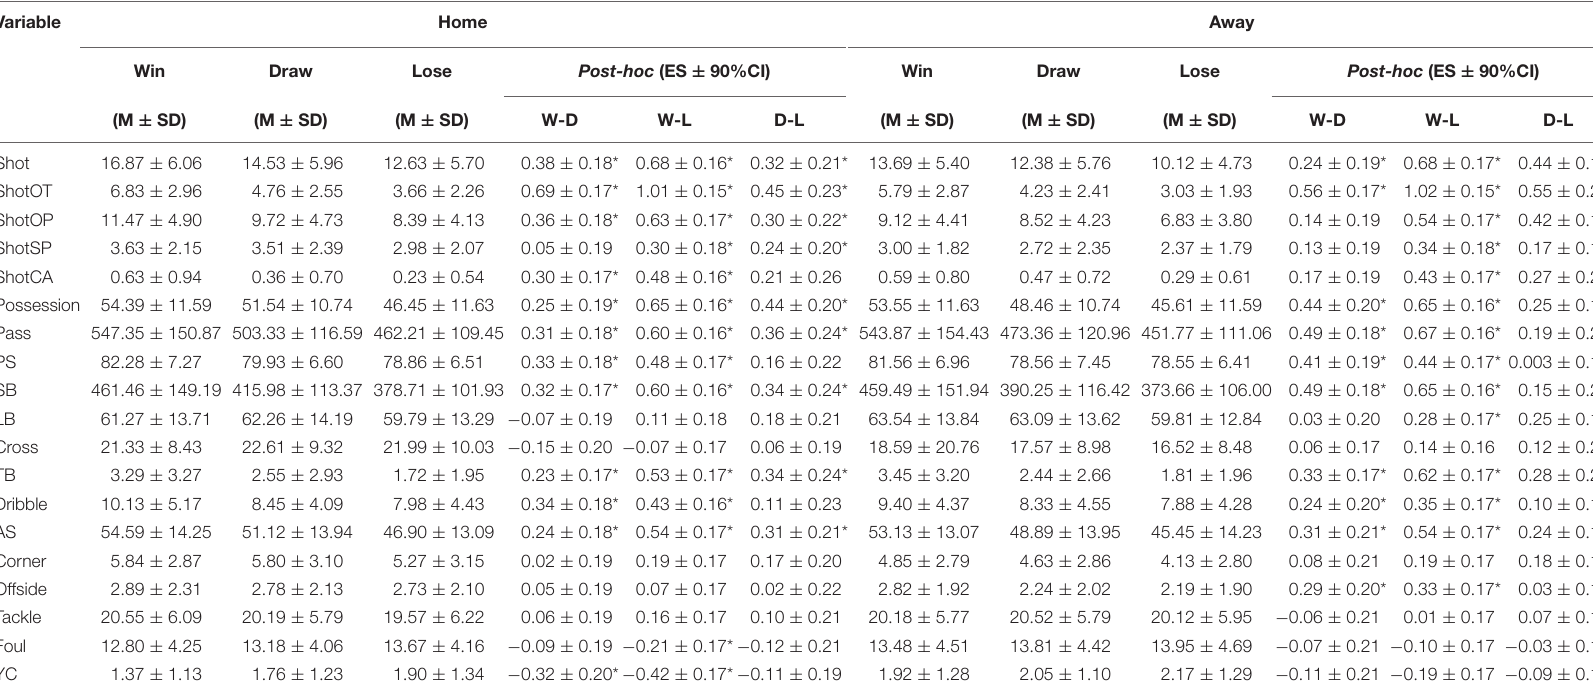
Descriptive statistics of teams in Tables 2 – 5 are presented as mean ± standard deviation (M ± SD). Effect sizes (ES) are presented as the magnitude of the true difference in means ± 90% confidence interval. Asterisks indicate that the p-value is lower than the significance level of 0.05. Abbreviations: ShotOT, shot on target; ShotOP, shot from open play; ShotSP, shot from set piece; ShotCA, shot from counter-attack; PS,